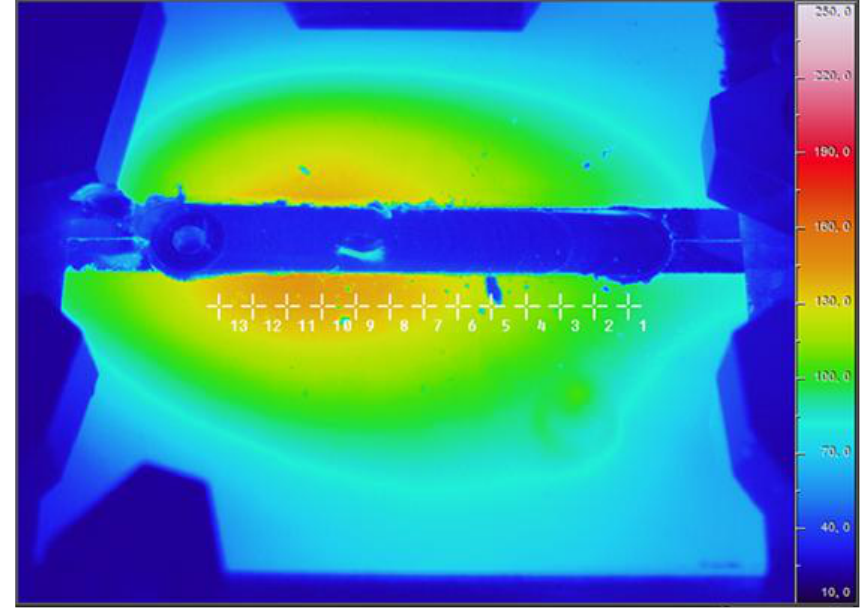
Figure 10. Example of infrared image. The marks indicate the points where temperatures are